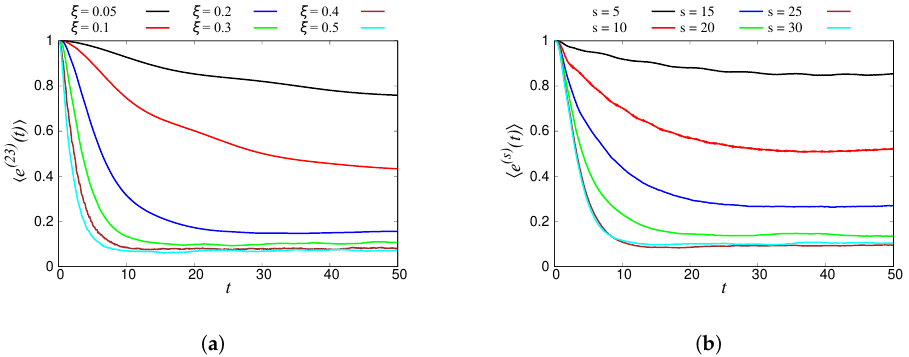
Figure 13. Normalized energy response of ( a ) the 23rd band for chains with different disorder, ξ , (= 18,38,58,78,98,118 ) , into bands, s , for the system with disorder and ( b ) different input tones, N ξ = 0.3. The data shown here were averaged in k -space over 100 realizations.